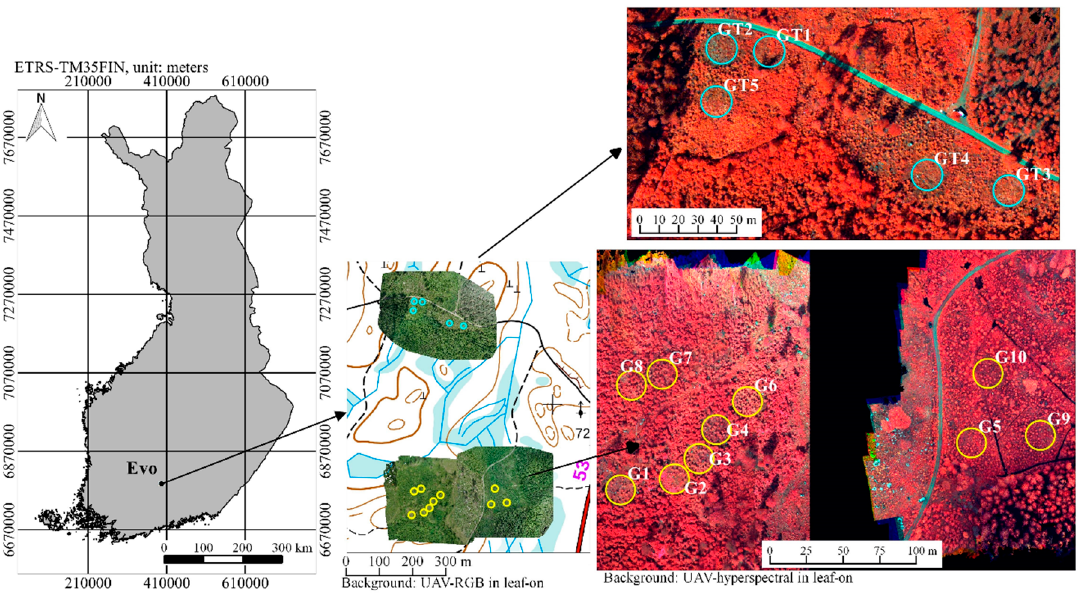
Figure 1. Map of study area and established sample plots in young seedling stand (northern image block) and in advanced seedling stand (southern image blocks). Background: UAV-red, green, blue (RGB)-image mosaics (middle map) and UAV-hyperspectral image mosaics (right maps) visualized coloured-infrared (885.9 nm, 605.4 nm, 513.5 nm) in leaf-on conditions.